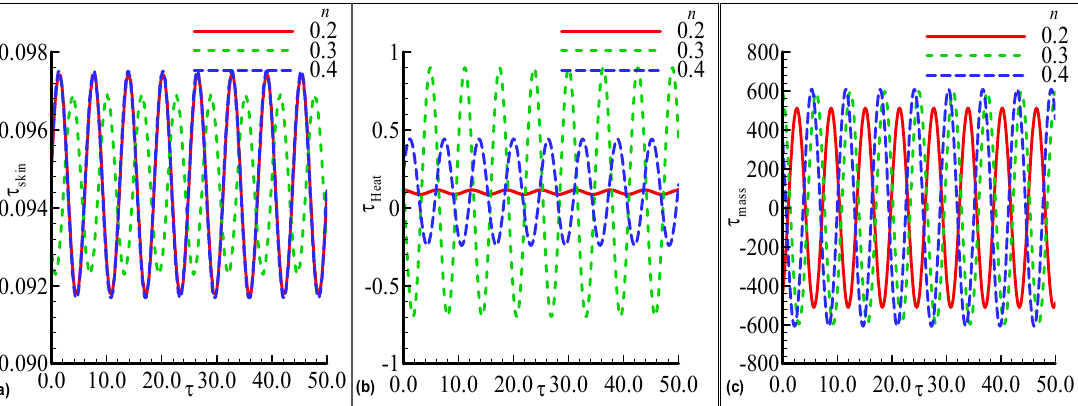
Figure 4. The physical profiles for τ skin , τ heat , and τ mass with choices of n = 0.2, 0.3, and 0.4 and fixed Pr = 7.0, S c = 0.2, λ t = 0.7, λ c = 0.6, E = 0.1, γ = 0.3, λ = 0.5, β = 0.2 and (cid:101) = 0.05.